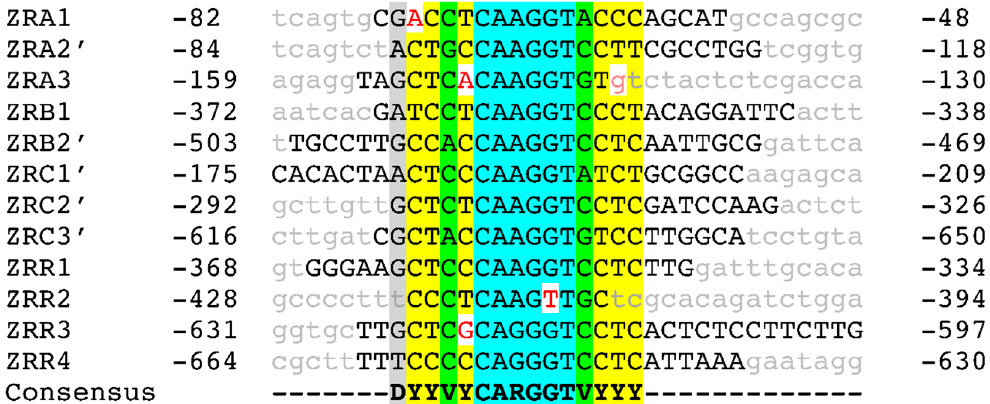
Figure 5. Alignment of DNA sequences protected against DNase I digestion from the DNA fragments used for EMSA analyses. Protected sequences are in capital letters whereas the surrounding sequences are indicated in gray lower case letters (D = A or G or T; V = A or G or C; R = A or G). ZR motifs labelled with a prime symbol indicate that the DNA sequence shown in the picture corresponded to that in the antiparallel strand.